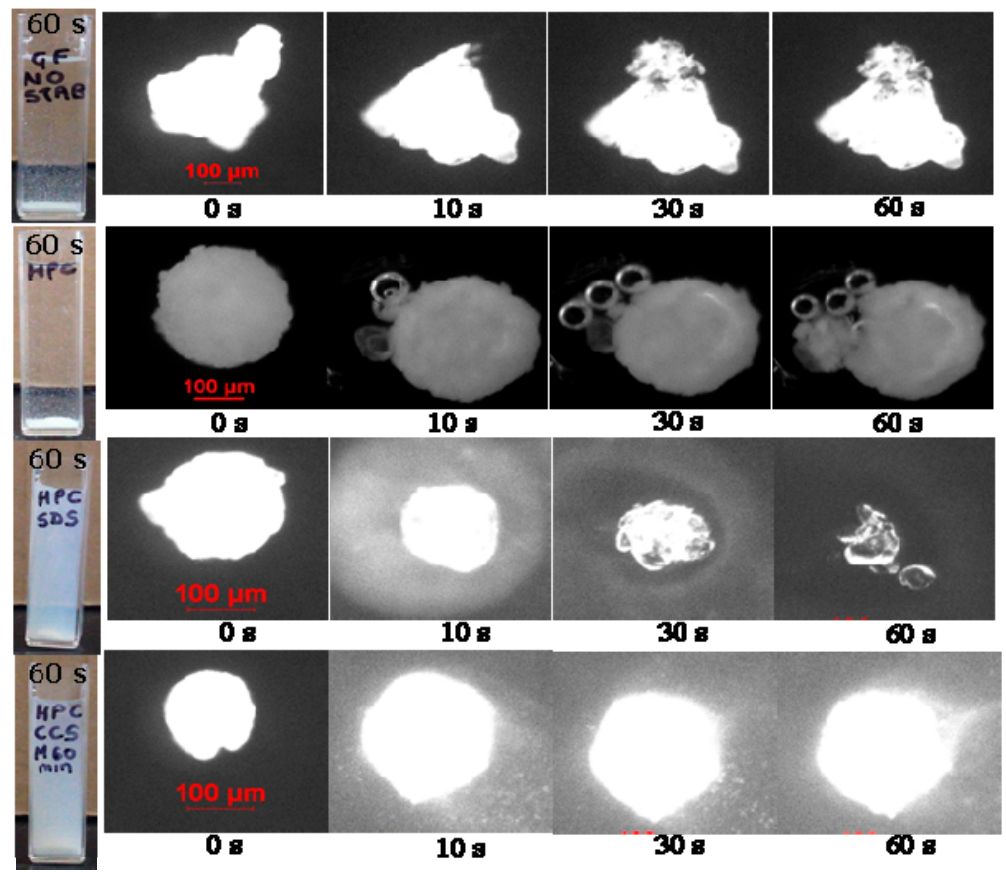
Figure 7. Images of redispersion dynamics of griseofulvin (GF) nanocomposite particles, which were prepared by fluidized bed coating of GF nanosuspension on Pharmatose carrier particles with various dispersants, in quiescent water (no external agitation/shear) ( left panel ), and after addition of a drop of water on a single nanocomposite particle, visualized under optical microscope ( right panel ). Nanocomposite formulations in the figure from top to bottom contain GF nanoparticles without stabilizers, GF nanoparticles with HPC, GF nanoparticles with HPC–SDS, and GF with HPC–croscarmellose sodium (CCS) milled for 60 min. (Adapted from Bhakay et al. [92] with permission from Springer Nature, www.springernature.com).